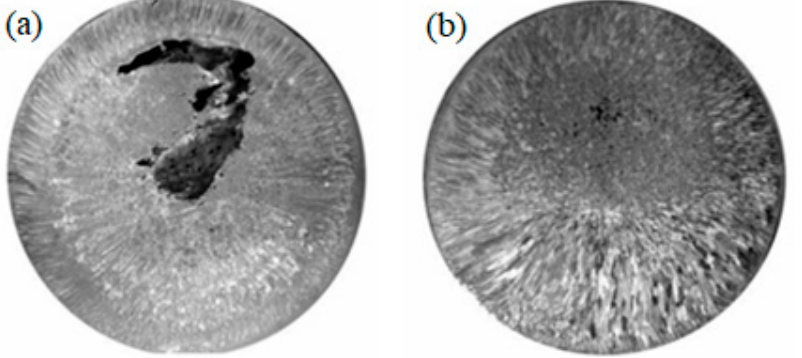
Figure 14. Macrostructure of the templates of pure zinc: ( a ) untreated sample for comparison, and ( b ) EMP processed sample [18]. ( b ) EMP processed sample